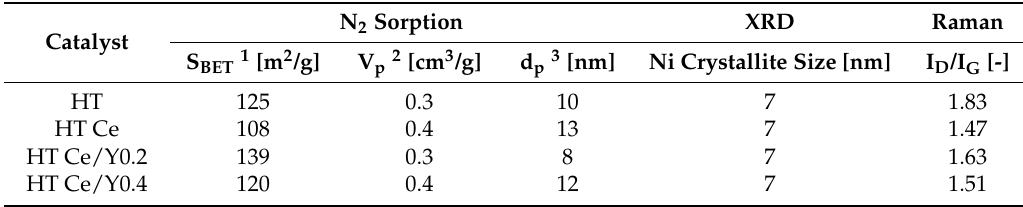
Table 4. Dry reforming of methane results at different